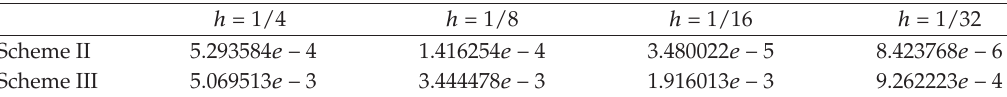
Table 2: The maximal errors of numerical solutions at t (cid:9) 10 with τ (cid:9) 0 . 1 for α (cid:9) 0 . 5 when p (cid:9) 4. h (cid:9) 1 / 4